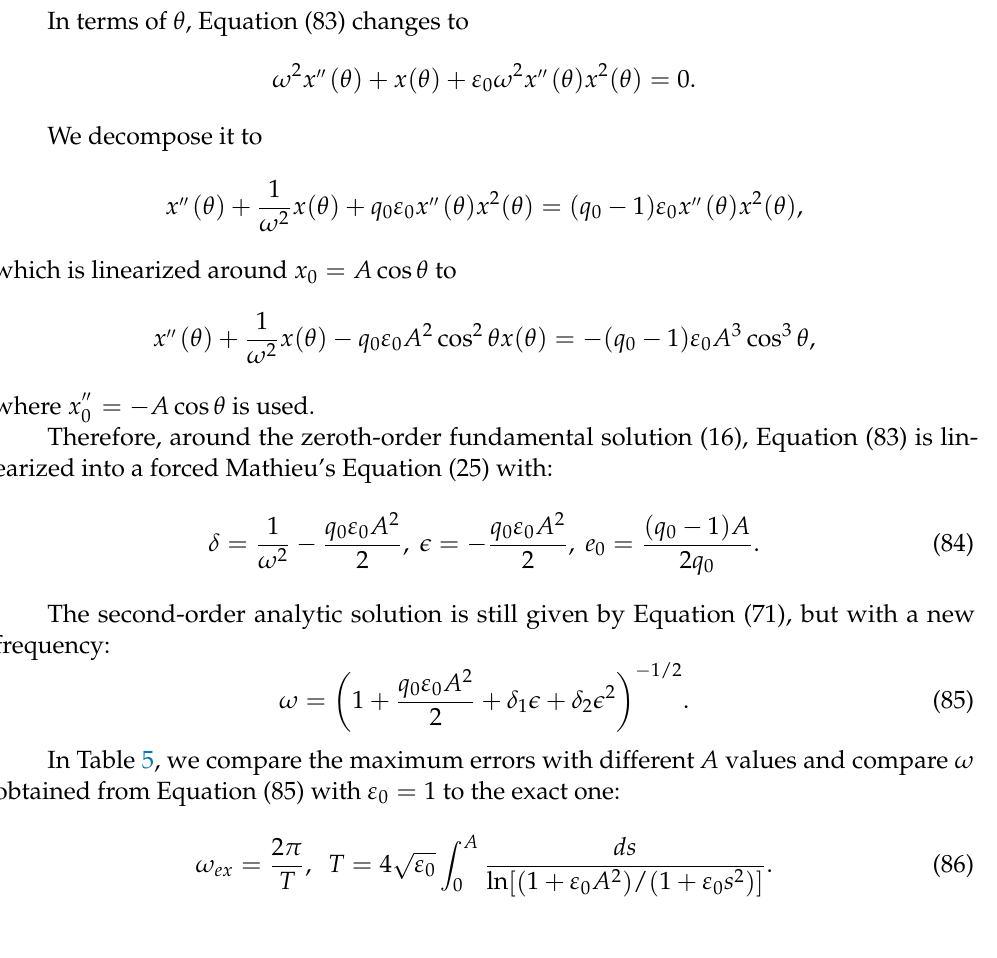
Table 5. Comparing the maximum errors (MEs) and frequencies for the analytic solutions of Example 5 with different A values obtained by the present method and comparing